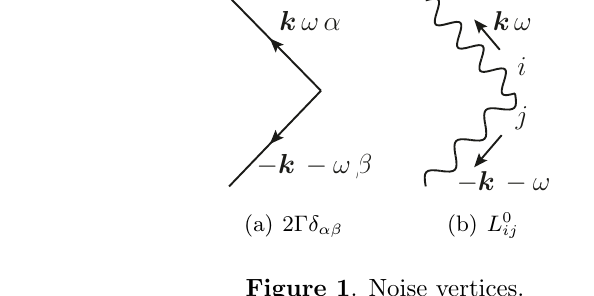
Figure 1 . Noise vertices.